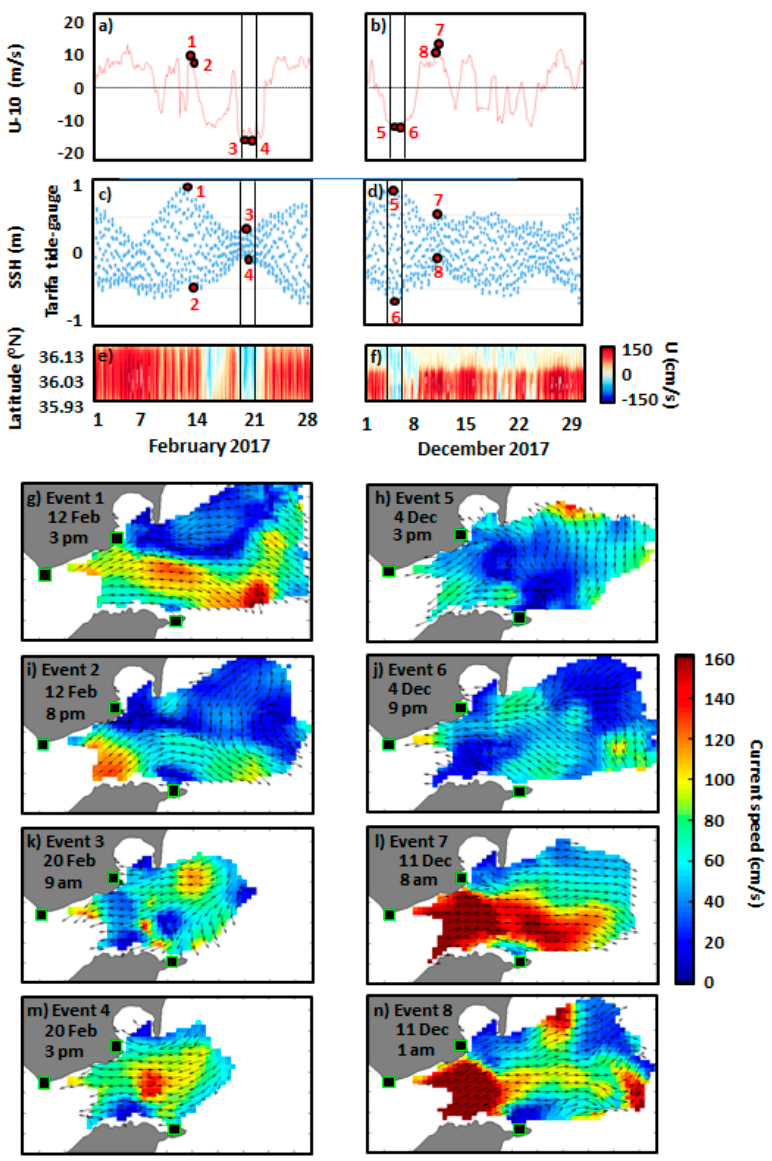
Figure 10. ( a , b ) Monthly time series of European Center of Medium Weather Forecast (ECMWF) 3-h zonal wind at 10 m height (U-10), spatially-averaged over the Strait of Gibraltar, for February and December 2017, respectively. Red dots denote specific selected events, defined in Table 2; ( c , d ) Monthly time series of hourly sea surface height. ( e , f ) Monthly Hovmöller diagrams of High-Frequency Radar (HFR)-derived zonal current speed at the selected transect in the Strait of Gibraltar. 2-day episodes of permanent flow reversal are marked with black boxes; ( g – n ) Hourly maps of HFR-derived surface circulation, corresponding to the eight selected events, labeled in the upper panels.